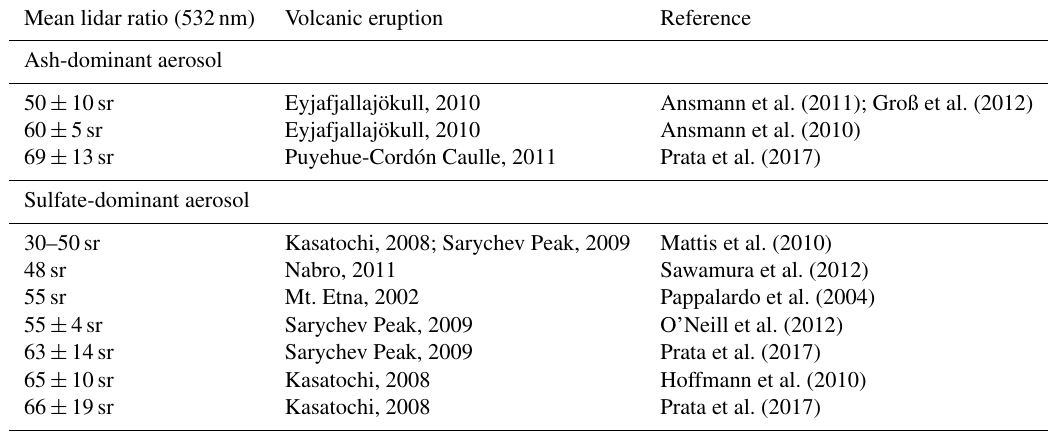
Table 3. Mean 532nm lidar ratios reported in the literature for volcanic ash and volcanic